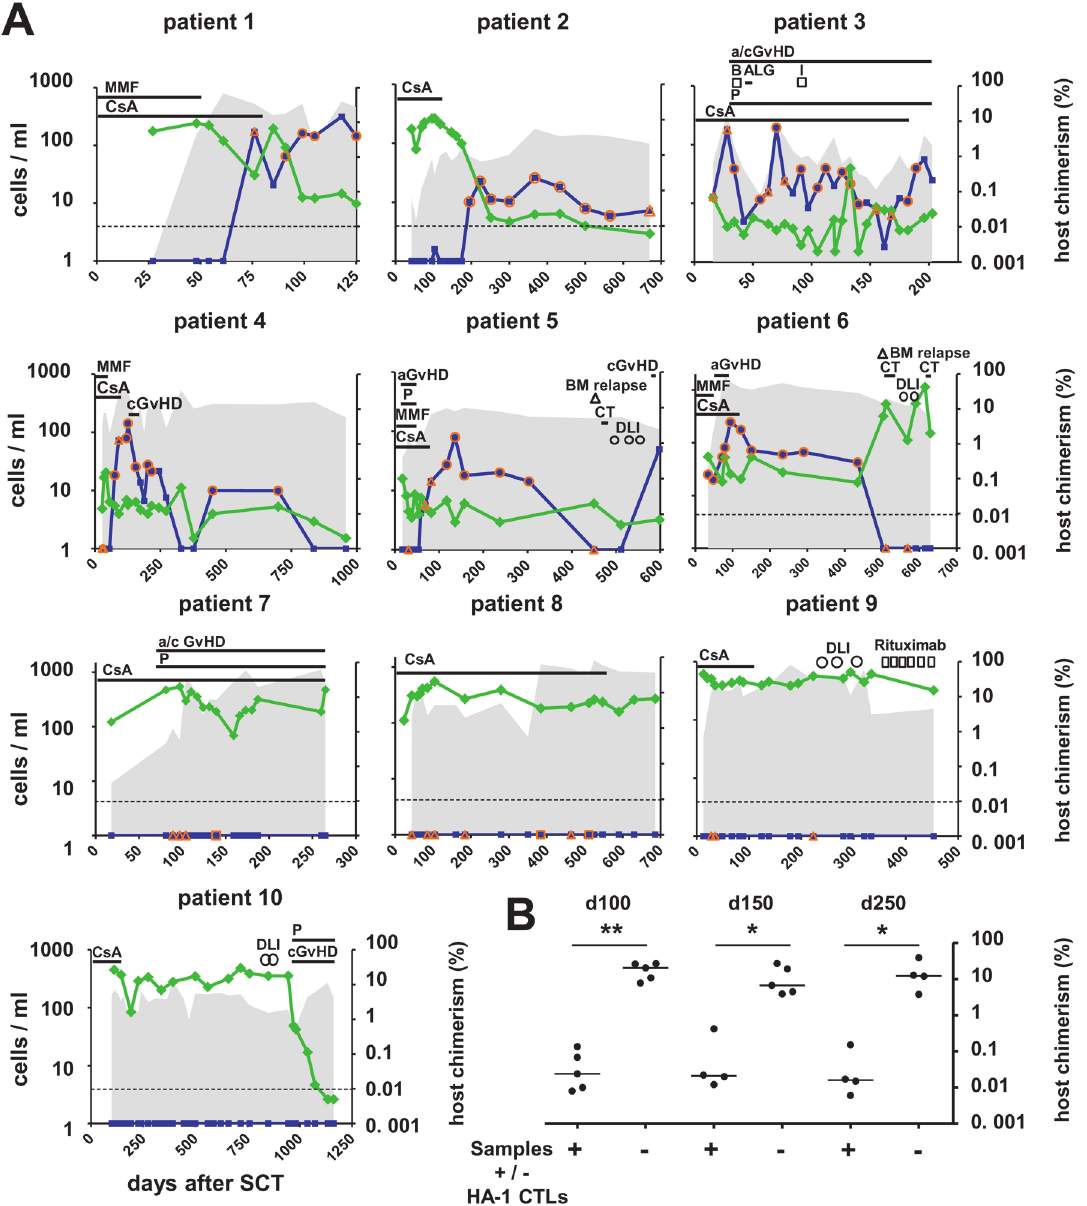
Fig 1. Kinetics of the donor HA-1 CTL response in relation to host chimerism in the peripheral blood. (A) Depicted are the results of 10 patients undergoing allogeneic HLA-matched, HA-1 mismatched SCT; x-axis: days after allogeneic SCT; left y-axis, blue squares and line: T-cells in absolute numbers per ml peripheral blood detected and calculated as described in Materials and Methods; open circles: samples from which HA-1 CTLs could be isolated capable of lysing Epstein-Barr virus/lymphoid cell lines (EBV LCLs) expressing the HA-1 H natural ligand; open triangles: samples with unsuccessful attempts to isolate HA-1 A2 tetramer staining cells; shaded areas: CD8 + T-cells in 10 3 cells per ml peripheral blood; right y-axis, green diamonds and line: host chimerism determined by highly sensitive mHag HA-1 (patient 1 – 2, 6 – 10) or H-Y (patient 3 – 5) specific quantitative PCR. Horizontal dotted line: lower detection limit for HA-1 H allele specific PCR: 1 host in 10 4 donor cells; the lower detection limit for H-Y specific PCR is 1 host in 10 5 donor cells; horizontal black bars indicate times of GVHD, immunosuppression (CsA, MMF, P, ALG, B and I) or CT, black open circles indicate DLI, black open triangles indicate relapse, black open squares indicate rituximab treatment, Abbreviations: CsA, cyclosporine A; MMF, mycophenolate mofetile; P, prednisolone; B, basiliximab; I, infliximab; ALG: anti-lymphocyte globulin; CT: chemotherapy. (B) Comparison of the host chimerism levels in samples with and without HA-1 CTLs collected on days 100, 150 and 250 (+/-27) after allogeneic SCT. The horizontal lines indicate the median values. Results from a two-tailed Mann- Whitney-U test are shown ( * p < 0.05).